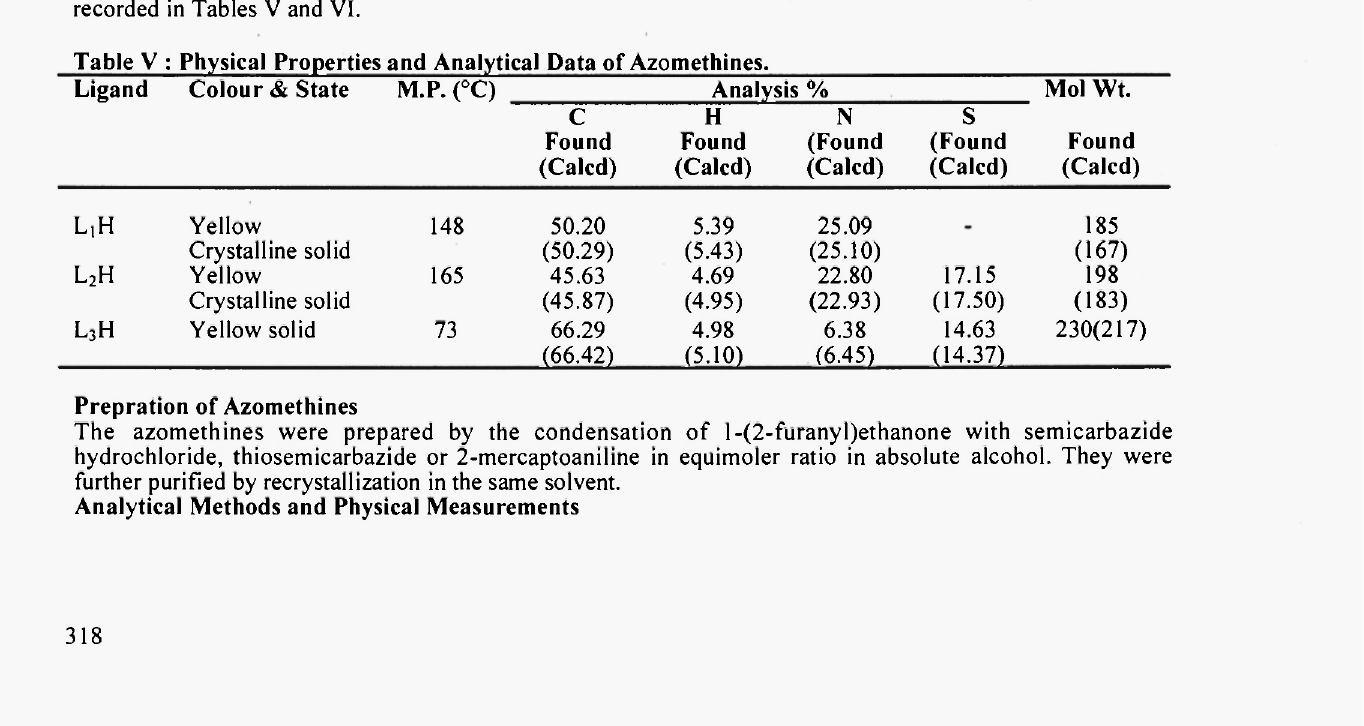
Table V : Physical Properties and Analytical Data of Azomethines. Ligand Colour &